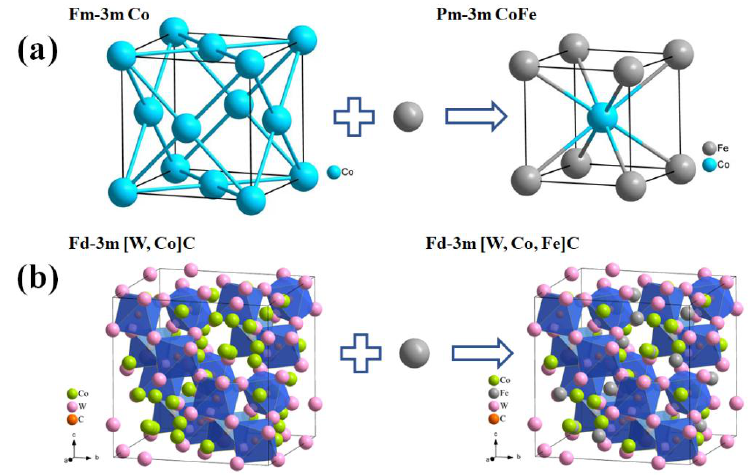
Figure 8. Crystal structure diagram of ( a ) binder phase of Co and CoFe and ( b ) eta phase of [W, Co]C and [W, Co, Fe]C.